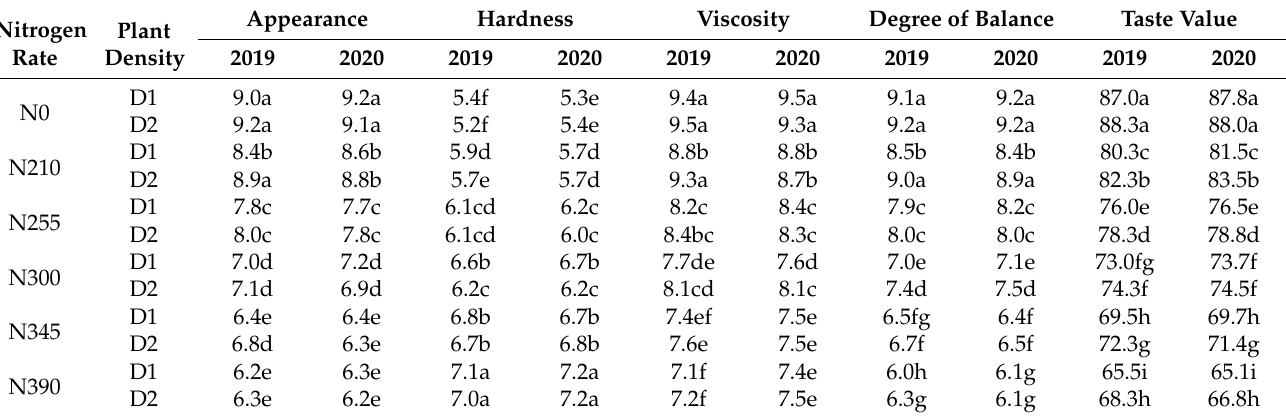
Table 8. Cooking/eating quality under combined nitrogen rate and planting density in saline soil.